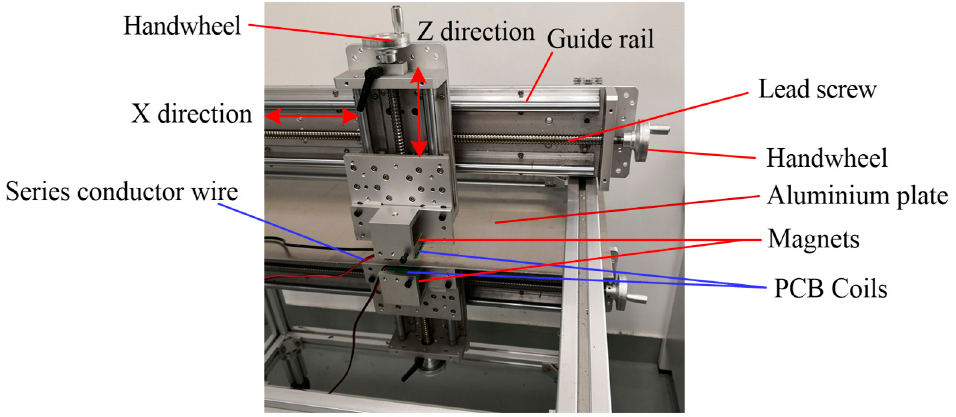
Figure 7. Experimental setup. The upper EMAT and lower EMAT are installed on the cross slides symmetrically, and printed circuit board (PCB) coils are series connected by conductor wire.